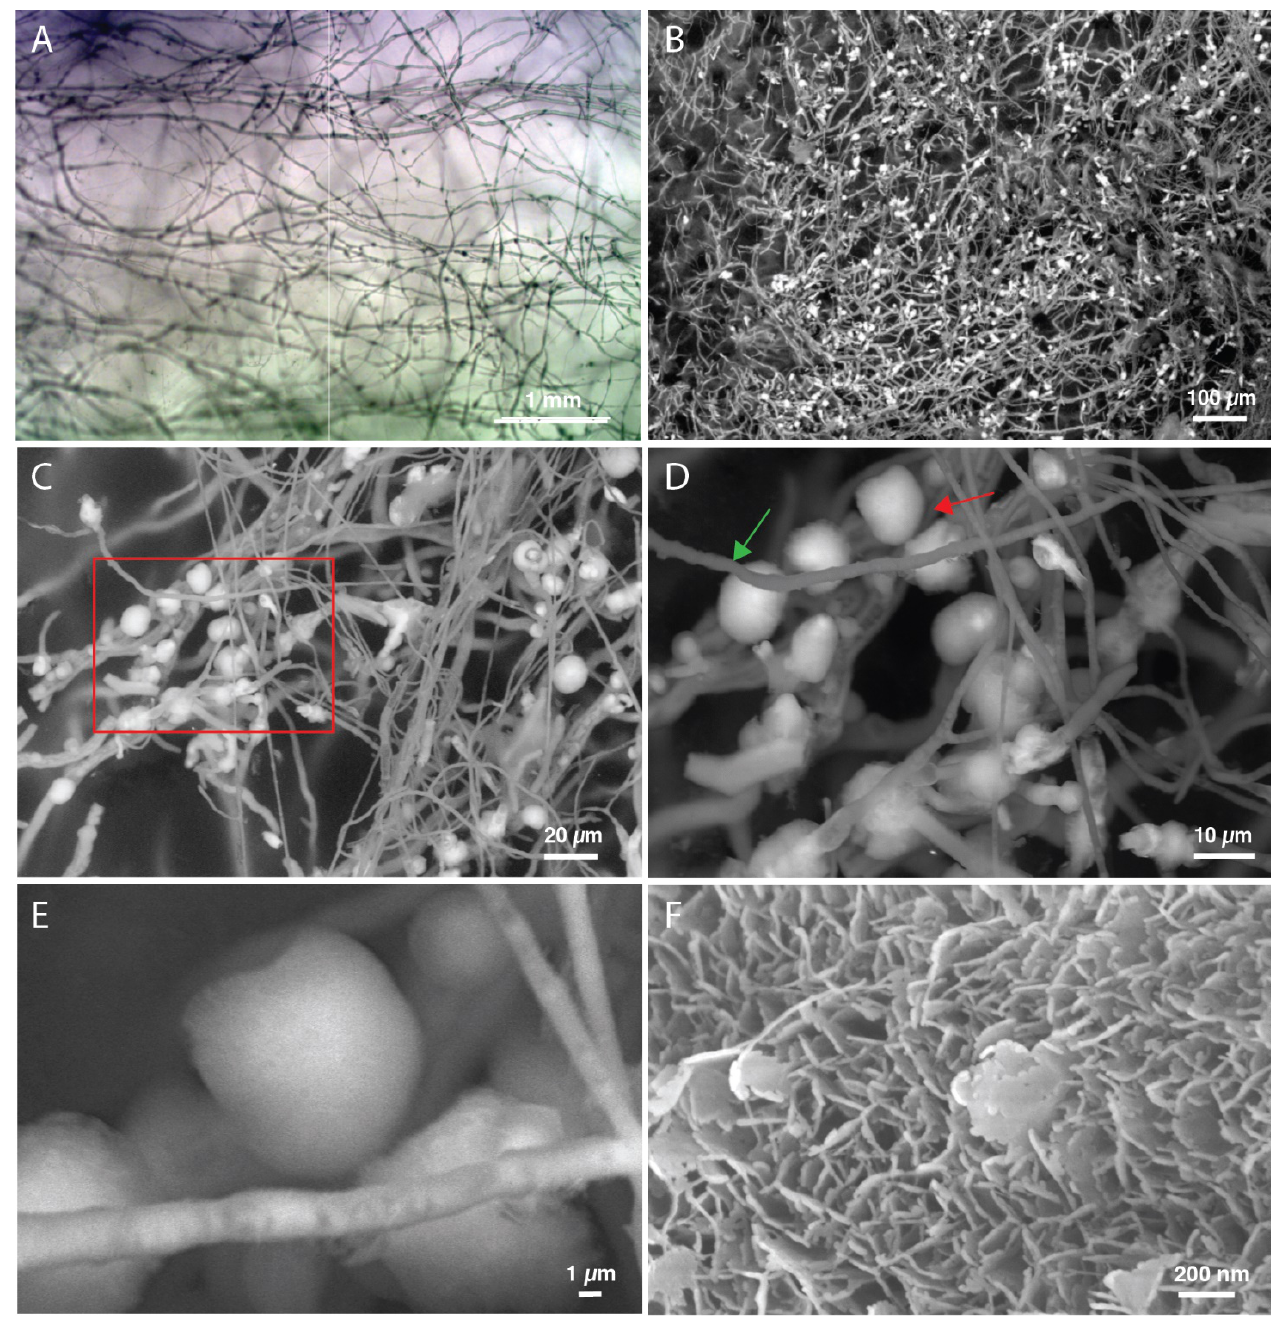
Figure 5. Micrographs of a Mn(II)-oxidizing fungal-bacterial co-culture containing a fungal species belonging to the Cladosporium genus within the Ascomycota phylum and a consortium of bacteria. ( A ) Light microscopy showing the com- plex network of hyphae. ( B ) SEM image of ( A ). ( C ) SEM images showing the association of hyphae and Mn oxide precip- itates. ( D ) Mn precipitates (red arrow) are deposited as globular particles on hyphal surfaces (green arrow). ( E ) Close-up of ( D ). ( F ) SEM image of Mn oxide nanosheets having undulated, almost serrated, margins.